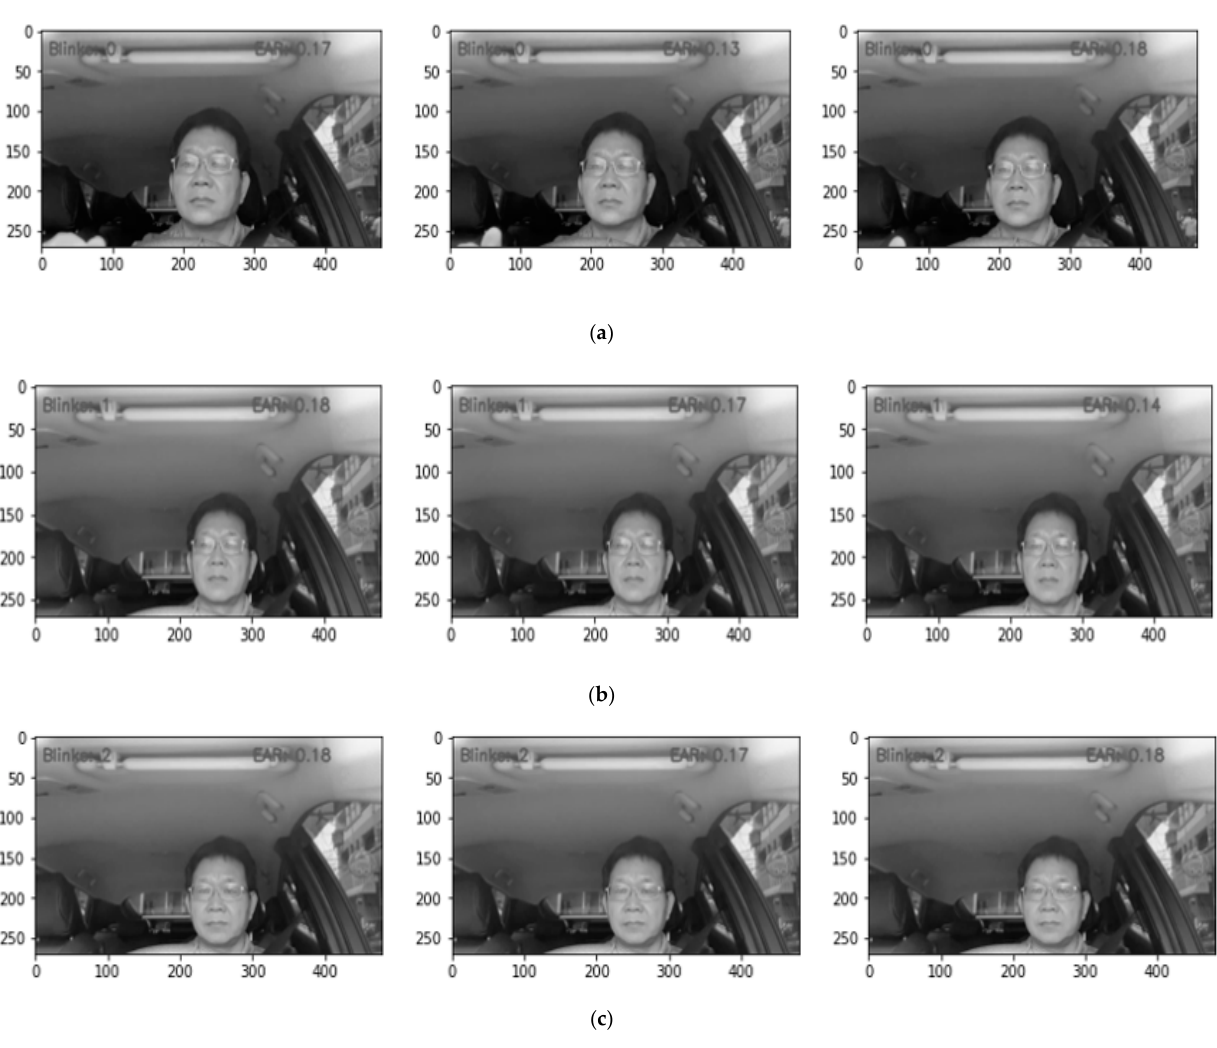
Figure 7. Video 1 eye blink prediction results frame by frame (threshold = 0.18). ( a ) The 1st blink started in the 3rd frame, the middle of the action in the 5th frame, and it ended in the 7th frame. ( b ) The 2nd blink started in the 1555th frame, the middle of the action was in the 1556th frame, and it ended in the 1557th frame. ( c ) The 3rd blink started in the 1563rd frame, the middle of the action was in the 1564th frame, and it ended in the 1565th